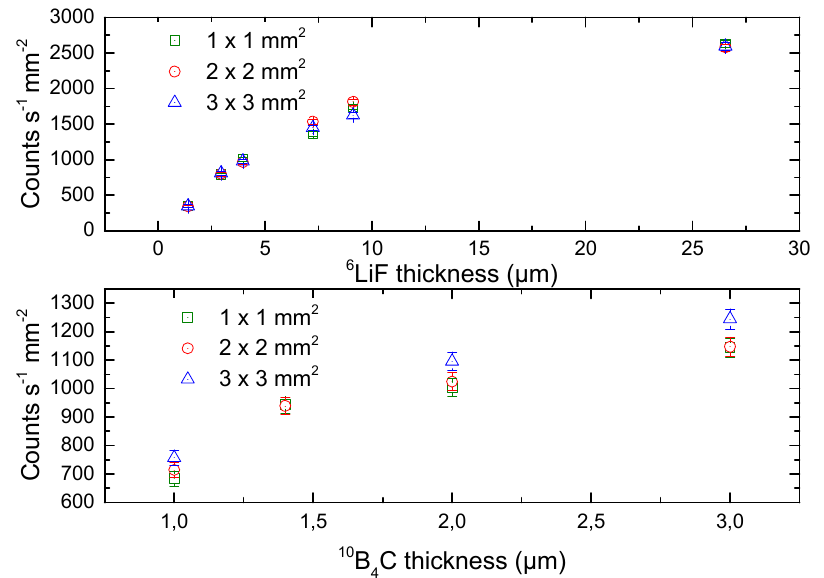
Figure 4. A correlation of thickness for both 6 LiF and 10 B 4 C converter layers with normalized surface area of three different detector sizes (1 mm × 1 mm, 2 mm × 2 mm, and 3 mm × 3 mm). The total count rate is shown on the y -axis.